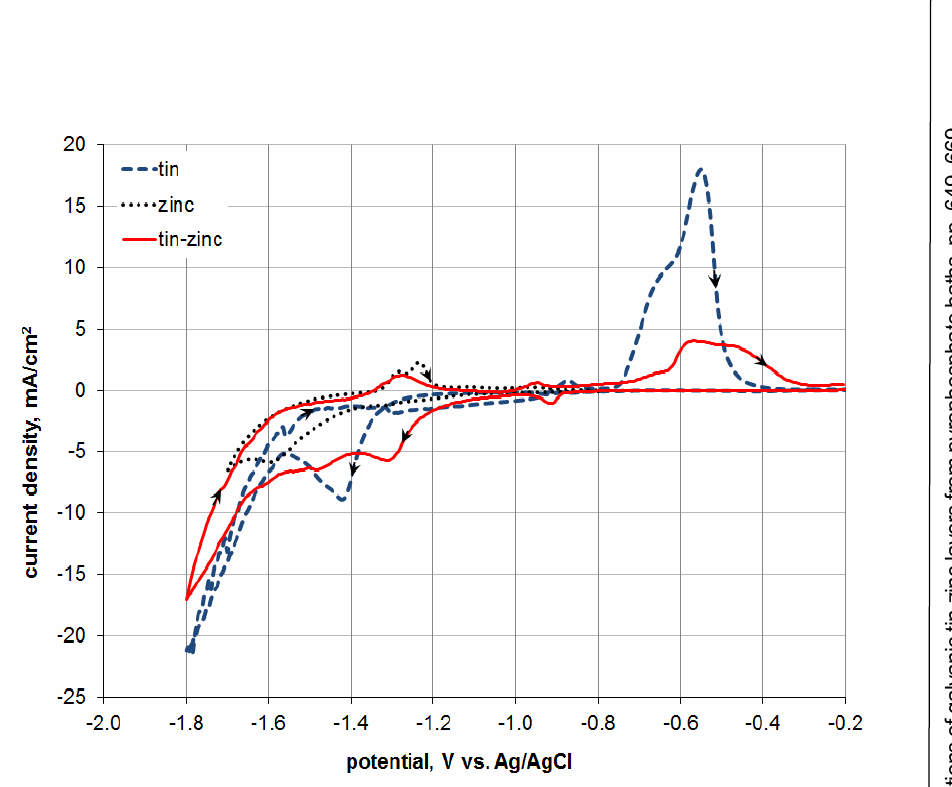
Figure 15 – Cyclic voltammogramms of zinc-, tin and tin-zinc electrodeposition in a pyrophosphate electrolyte with 0.05 mol/l Zn or/and 0.05 mol/l Sn, 0.25 mol/l K4P2O7 and 1g/l gelatine at 60°C and pH=9.3; AE: copper; v = 5 mV/s. The arrows indicate the scan direction. Рис . 15 – Циклическая вольтамперограмма электрохимических осаждений цинка , олова и сплава цинк - олово в пирофосфатном электролиту с 0.05 mol/l Zn и / или 0.05 mol/l Sn, 0.25 mol/l K4P2O7 и 1g/l желатина при 60°C и pH=9.3; AE: медь ; v = 5 mV/s. Стрелка обозначает направление сканирования . Slika 15 – Cikli č ni voltamogrami elektrohemijski nataloženog cinka, kalaja i legure cinka i kalaja u pirofosfatnom elektrolitu su 0.05 mol/l Zn i/ili 0.05 mol/l Sn, 0.25 mol/l K4P2O7